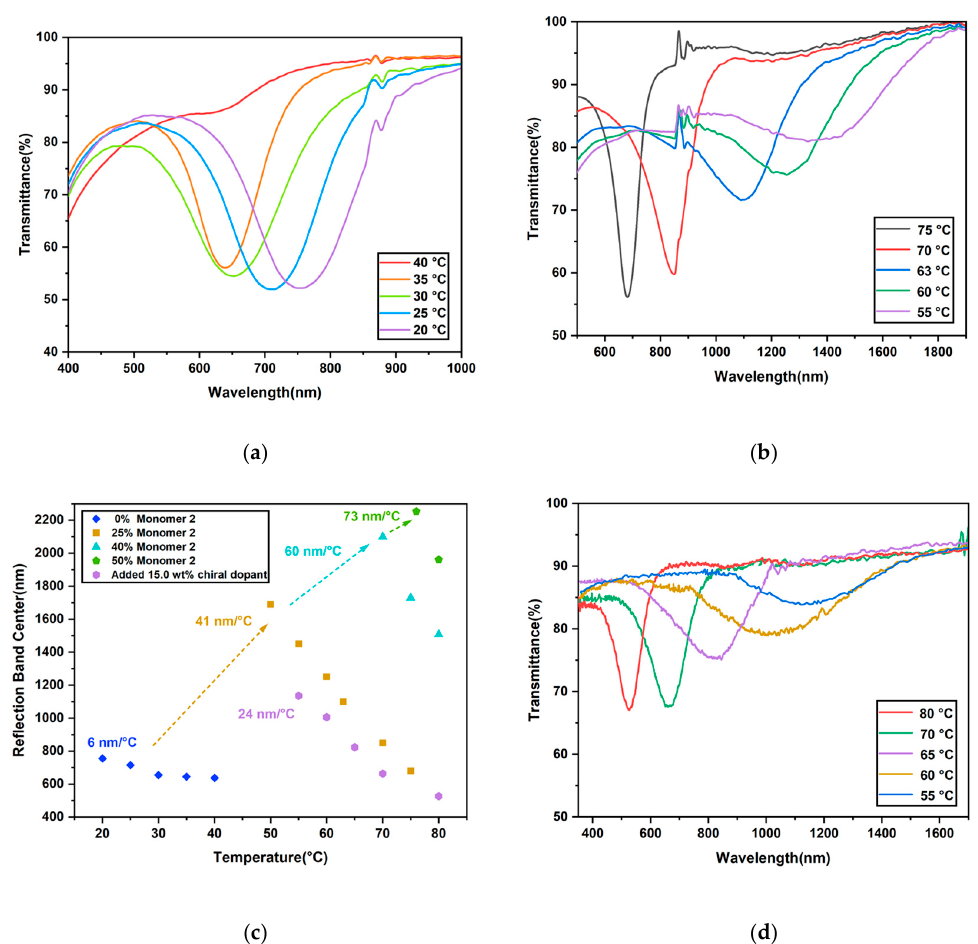
Figure 5. ( a ) Transmittance spectra of the oligomer with no Monomer 2 upon cooling. ( b ) Transmittance spectra of oligomer with 25% Monomer 2. ( c ) The central reflection wavelength of oligomers with different concentrations of Monomer 2 as a function of temperature upon cooling. In addition, the data for the oligomer with 50% Monomer 2 and an additional 15% chiral dopant is shown. ( d ) Transmittance spectra of the oligomer with 50% Monomer 2 after mixing with additional 15.0 wt% chiral dopant upon cooling.